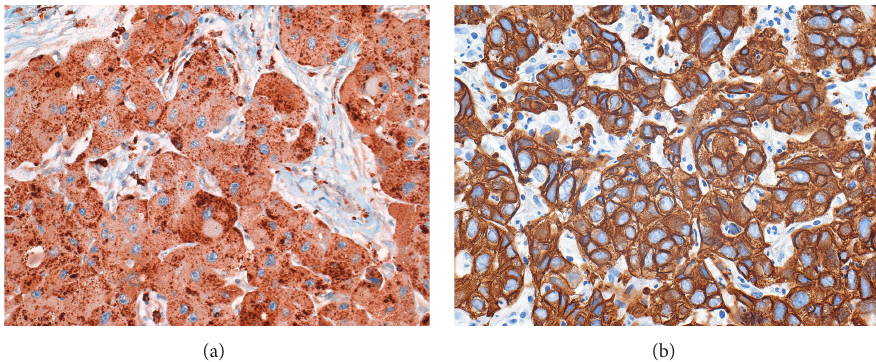
F 4: (a) Original magni�cation 100�. Fibrolamellar carcinomas express CD68 with a characteristic granular cytoplasmic staining pattern. CD68 stains lysosomes within the cytoplasm of the tumor cells. (b) Original magni�cation 160�. Fibrolamellar carcinomas strongly express cytokeratin